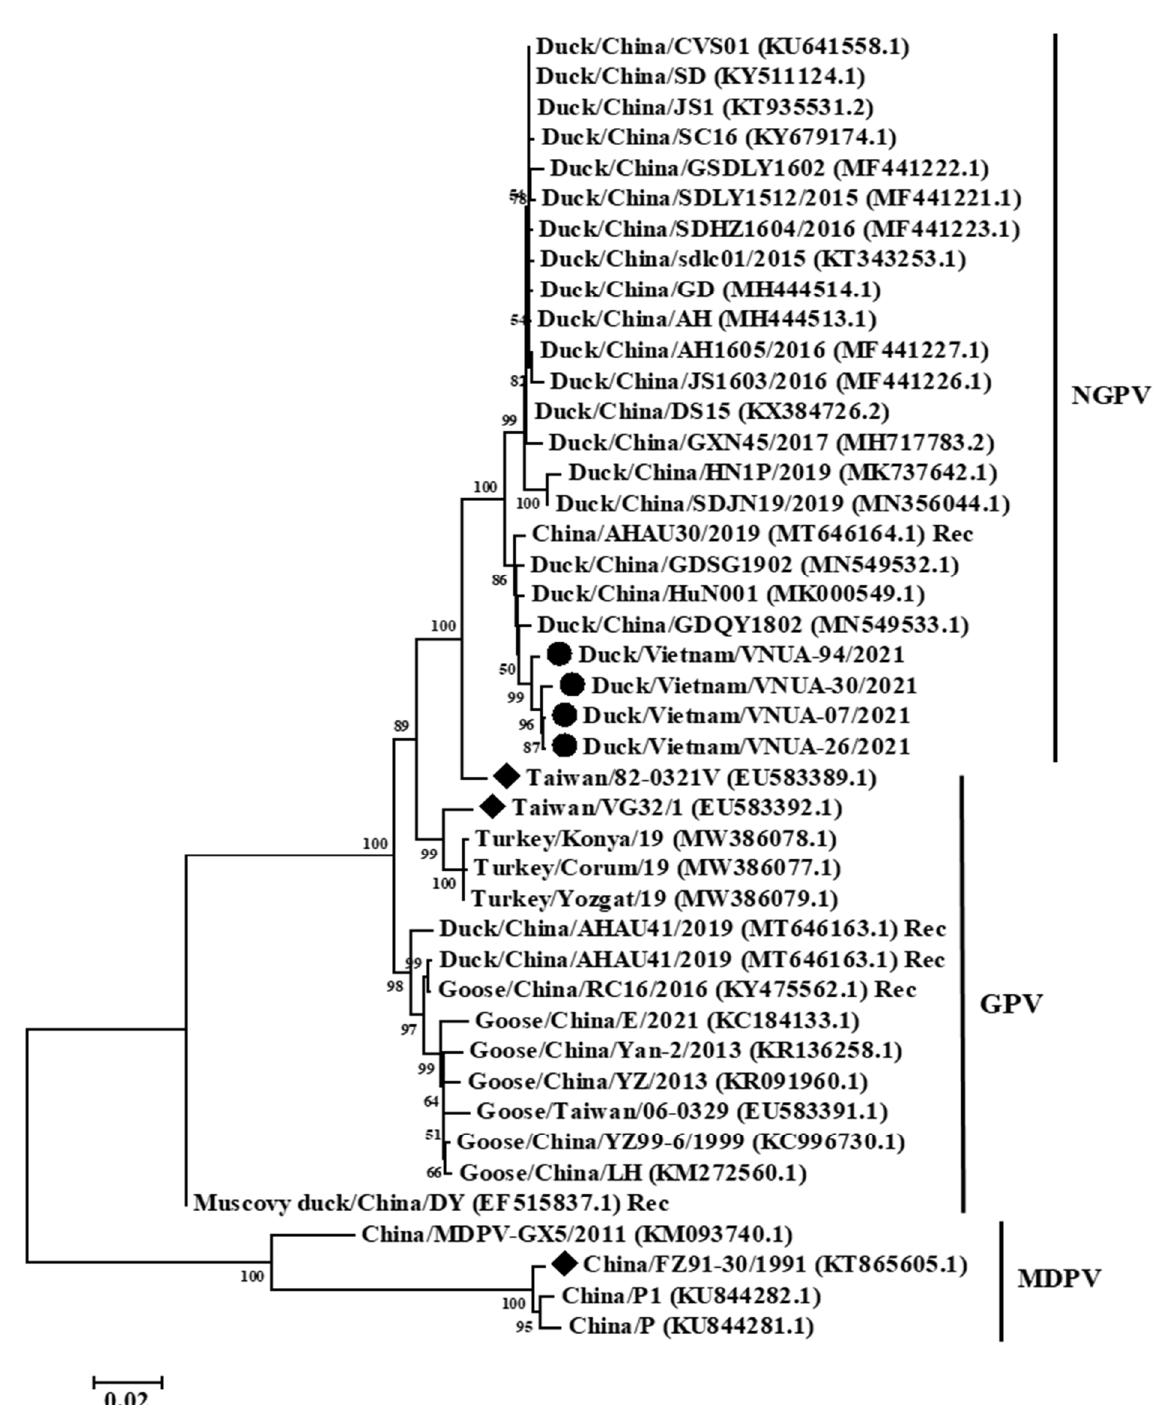
Figure 2. Phylogenetic trees of the near-complete genome (4750 bp) sequences of Vietnamese parvovirus strains compared with those available in GenBank. GenBank sequences are indicated by the country name/accession number. The maximum likelihood method in the MEGA6 software was used to establish phylogenetic trees (1000 bootstrap replicates). Numbers at each branch point indicate bootstrap values ≥ 50% in the bootstrap interior branch test. The current Vietnamese and vaccine strains are indicated by circles and diamonds, respectively.